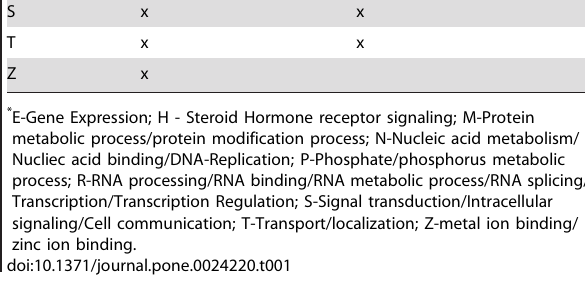
Figure 3. Network overlap. Top 2% overlap of NIMMI prioritized networks in InCHIANTI, Korean and GAIN controls datasets shows 38 networks that are common to all three datasets. Five networks are common to InCHIANTI and GAIN controls datasets only. Korean and GAIN controls datasets have seven networks in common and four networks are common between InCHIANTI and Korean datasets. Ten networks are specific to InCHIANTI dataset, whereas Korean and GAIN controls datasets have 8 and 7 networks, respectively.